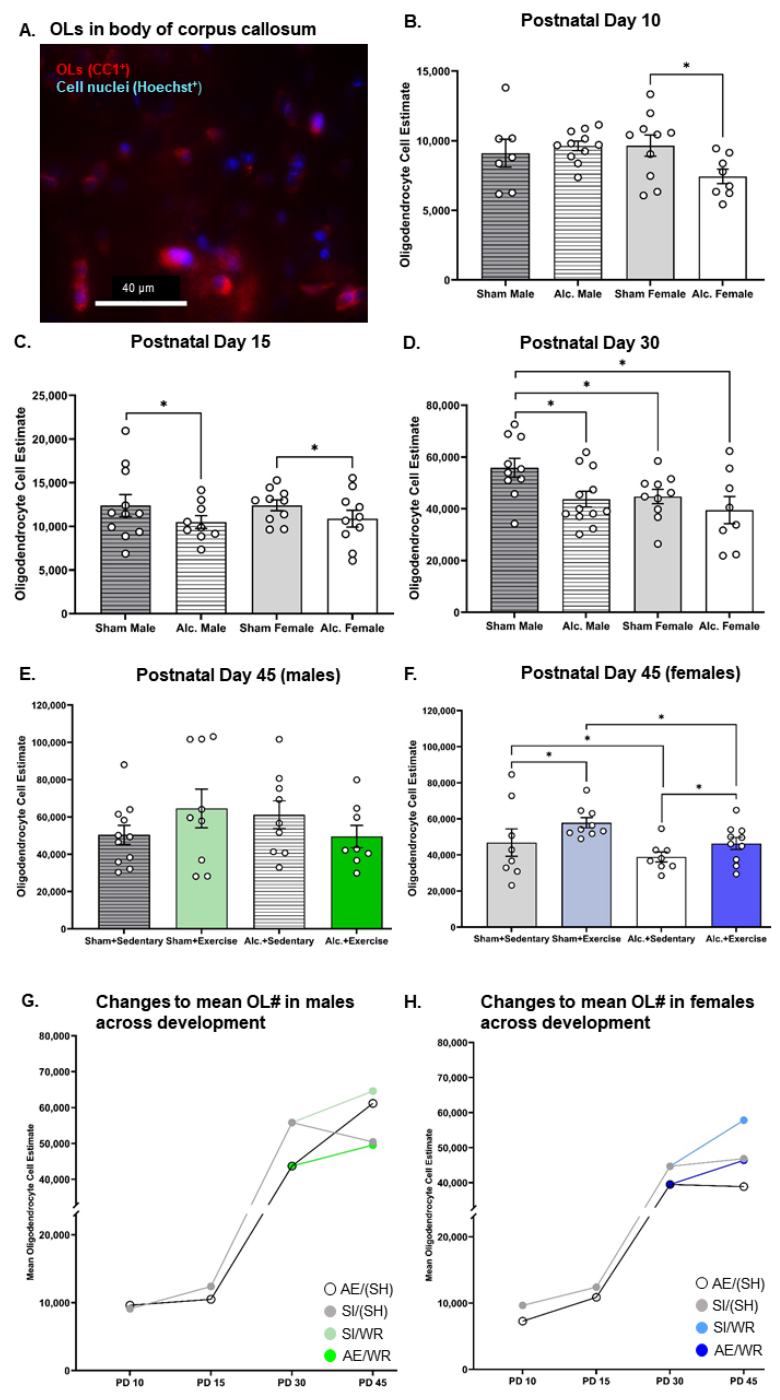
Figure 2. OL quantification in the body of CC from PD 10 to 45. ( A ) Example of fluorescent staining used to visualize OLs in CC, scale bar = 50 µ m; ( B – D ) Comparison of the number of OLs in the body of CC in brain tissue extracted from AE and SI rats from both sexes; ( E , F ) Comparison of the number of OLs in the body of CC in SI/SH, SI/WR, AE/SH, and AE/WR male ( E ) and female ( F ) rats. Each data point in graphs B-F represents the mean estimate per rat and error bars represent ± SEM, * p ≤ 0.05; ( G , H ) Trajectories of OL differentiation across all time points in the male ( G ) and female ( H ) brain in all postnatal treatment and intervention